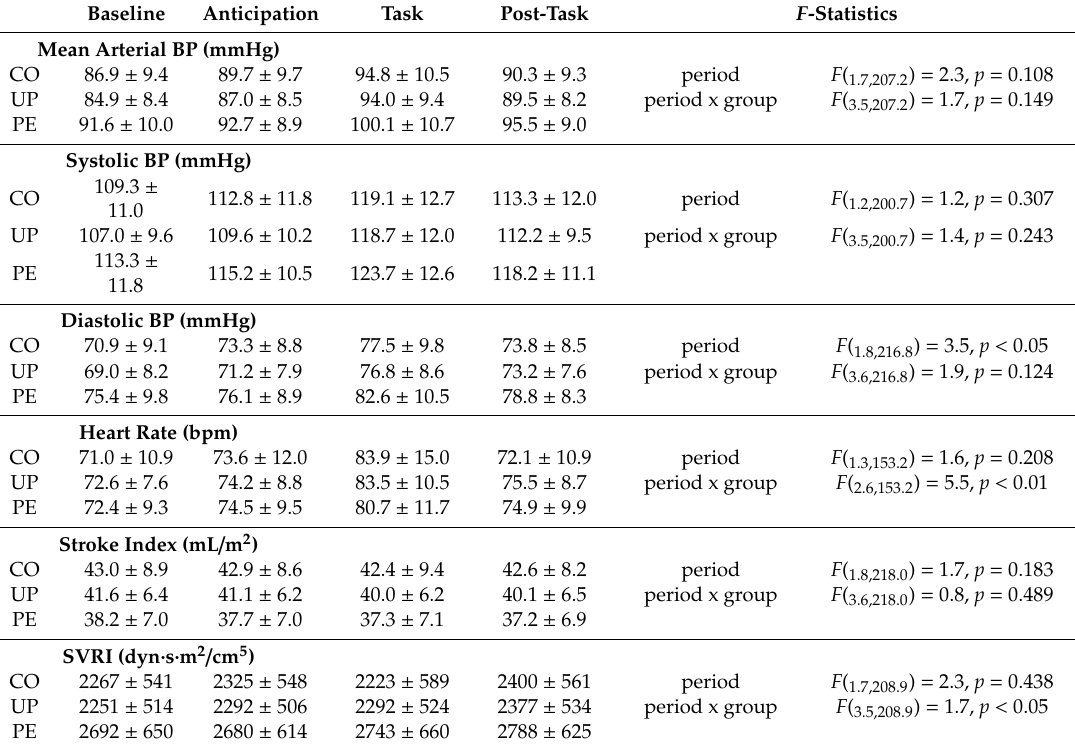
Table 1. Hemodynamic variables (mean ± SD) of participants, and statistical results for group di ff erences in response to the stress manipulation. CO: women without gestation during the last three years; UP: women with uncomplicated pregnancies; PE: women with a history of preeclampsia; BP: blood pressure; SVRI: systemic vascular resistance